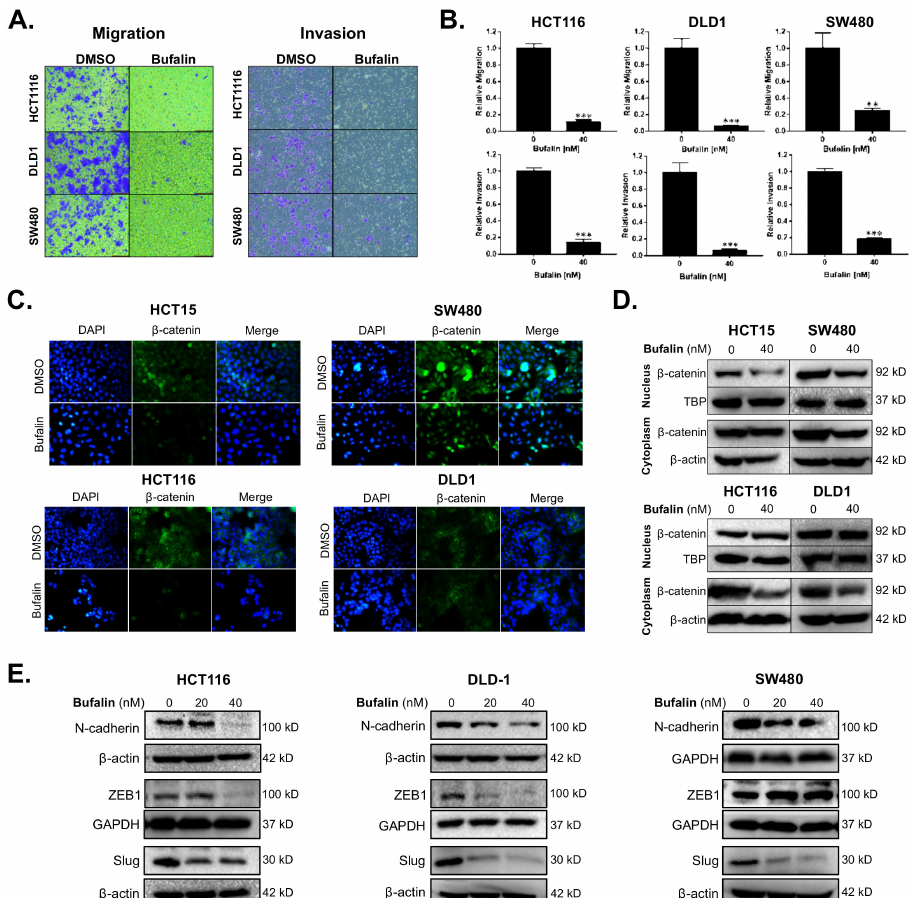
Figure 1. Bufalin inhibits epithelial–mesenchymal transition, β -catenin nuclear translocation, and metastatic properties of colorectal cancer cells. ( A ) Representative images of transwell migration and invasion assays for HCT116, DLD1 and SW480 cells after 48 h of treatment with 40 nM bufalin. ( B ) Quantitation of transwell migration and invasion assays revealing that 40 nM bufalin has a significant inhibitory effect on pro-metastatic migratory and invasive properties in conditions of chemotaxis for HCT116, DLD1, and SW480 CRC cells. ( C ) Immunofluorescence staining showing reduced translocation of nuclear β -catenin in HCT15 and SW480 cell lines after 48 h of 40 nM bufalin treatment and reduced cytoplasmic expression of β -catenin in HCT116 and DLD1 cell lines, which did not show visual evidence of nuclear translocation at baseline, after 24 h of 40 nM bufalin treatment. ( D ) Western blot results demonstrating reduced nuclear β -catenin expression in HCT15 and SW480 CRC cells, and reduced cytoplasmic β -catenin expression in SW480, HCT116, and DLD1 CRC cells after 40 nM bufalin treatment. ( E ) Western blot results showing that bufalin potently inhibits the expression of EMT marker N-cadherin and EMT transcription factors ZEB1 and Slug (** p < 0.01, *** p < 0.001, images at 10 ×